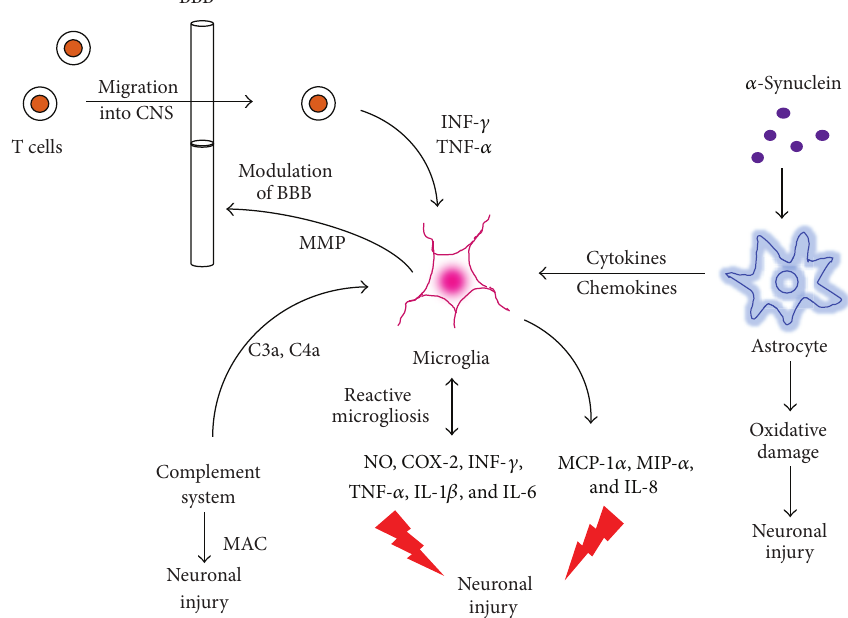
Figure 1: Microglial and astroglial cells become activated during the pathogenesis of Parkinson’s disease under the influence of various proinflammatory triggers, including 𝛼 -synuclein, the complement system, and cytokines released from infiltrated T cells. Activated microglial and astroglial cells further release various neuroinflammatory mediators, including NO, COX-2, IFN- 𝛾 , TNF- 𝛼 , IL-1 𝛽 & IL-6, chemokines including MCP-1 𝛼 , MIP- 𝛼 and CXCL-8, and MAC which have deleterious effect on neuronal survival. Abbreviations: NO: nitric oxide, COX-2: cyclooxygenase, INF- 𝛾 : interferon- 𝛾 , TNF- 𝛼 : tumor necrosis factor- 𝛼 , IL-1 𝛽 : interleukin-1 𝛽 , IL-6: interleukin-6, MCP-1 𝛼 : monocyte chemotactic protein-1, MIP- 𝛼 : microphage inflammatory protein, IL-8: interleukin-8, MAC: membrane attack complex, 𝛼 -syn: 𝛼 -synuclein, MMP: matrix metalloprotein, BBB: blood brain barrier, C3a: complement component 3a, and C4a: complement component